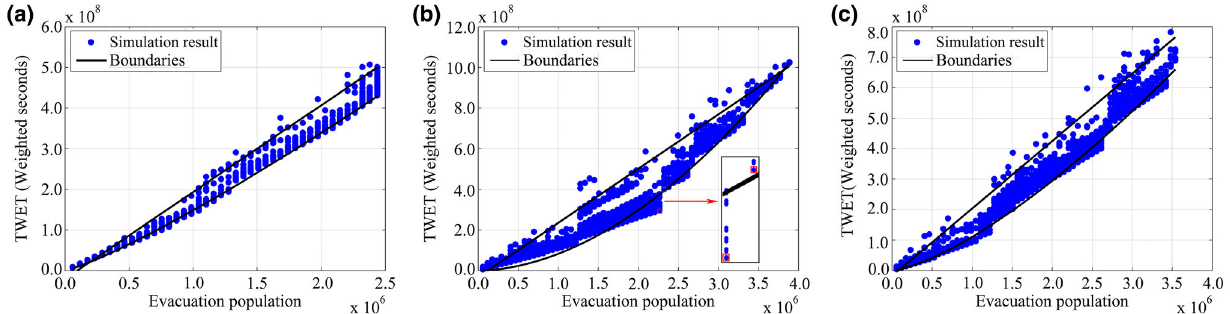
Fig. 12 Relationships between evacuation population and total weighted evacuation time (TWET) based on the joint relationships between population, TWET, and TSA. a – c Location 1, Location 2,